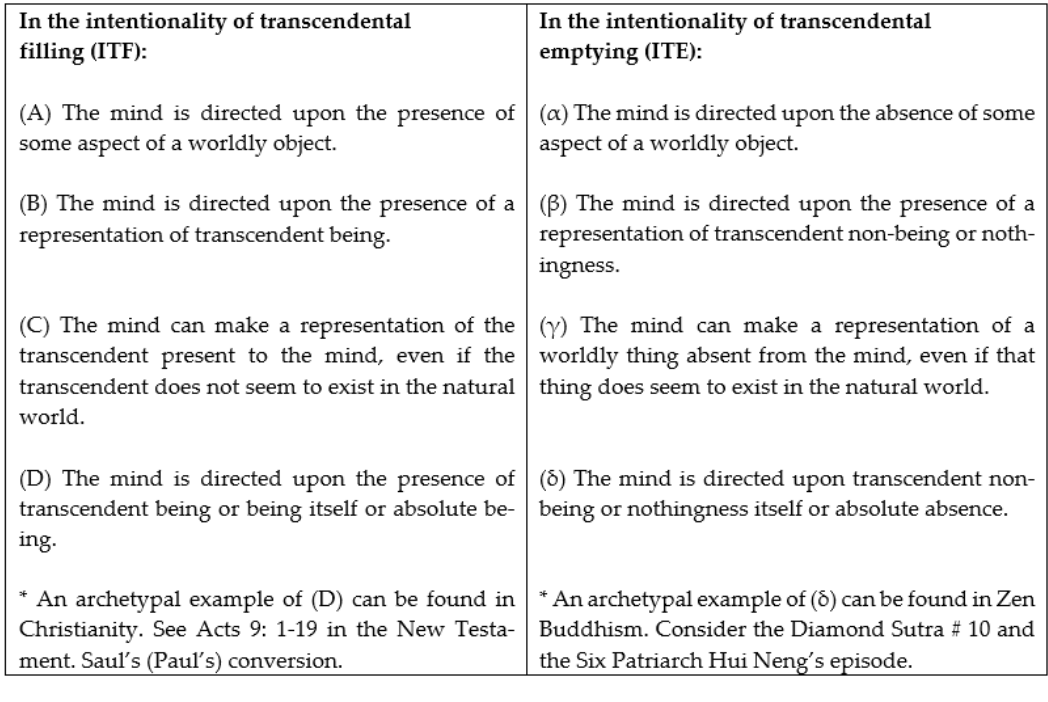
Figure 1. compare ITF and